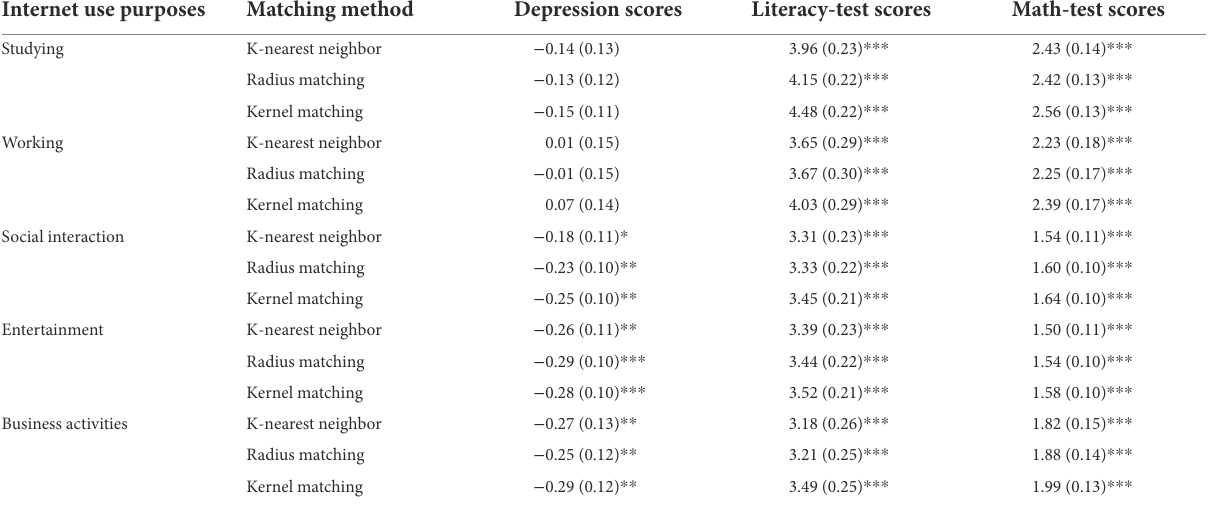
TABLE 6 Relationship between Internet use purposes and mental health.